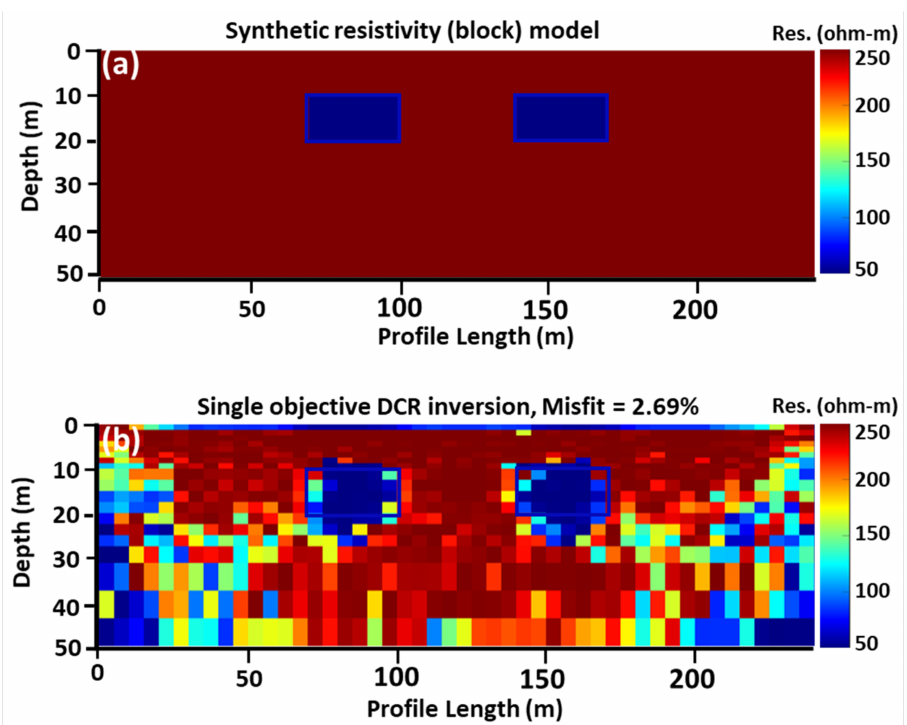
Figure 14. Negative anomaly model inversion using the single objective global optimization method; ( a ) synthetic dc-resistivity model and ( b ) single object inverted resistivity model. The dark blue line is used to mark the anomaly